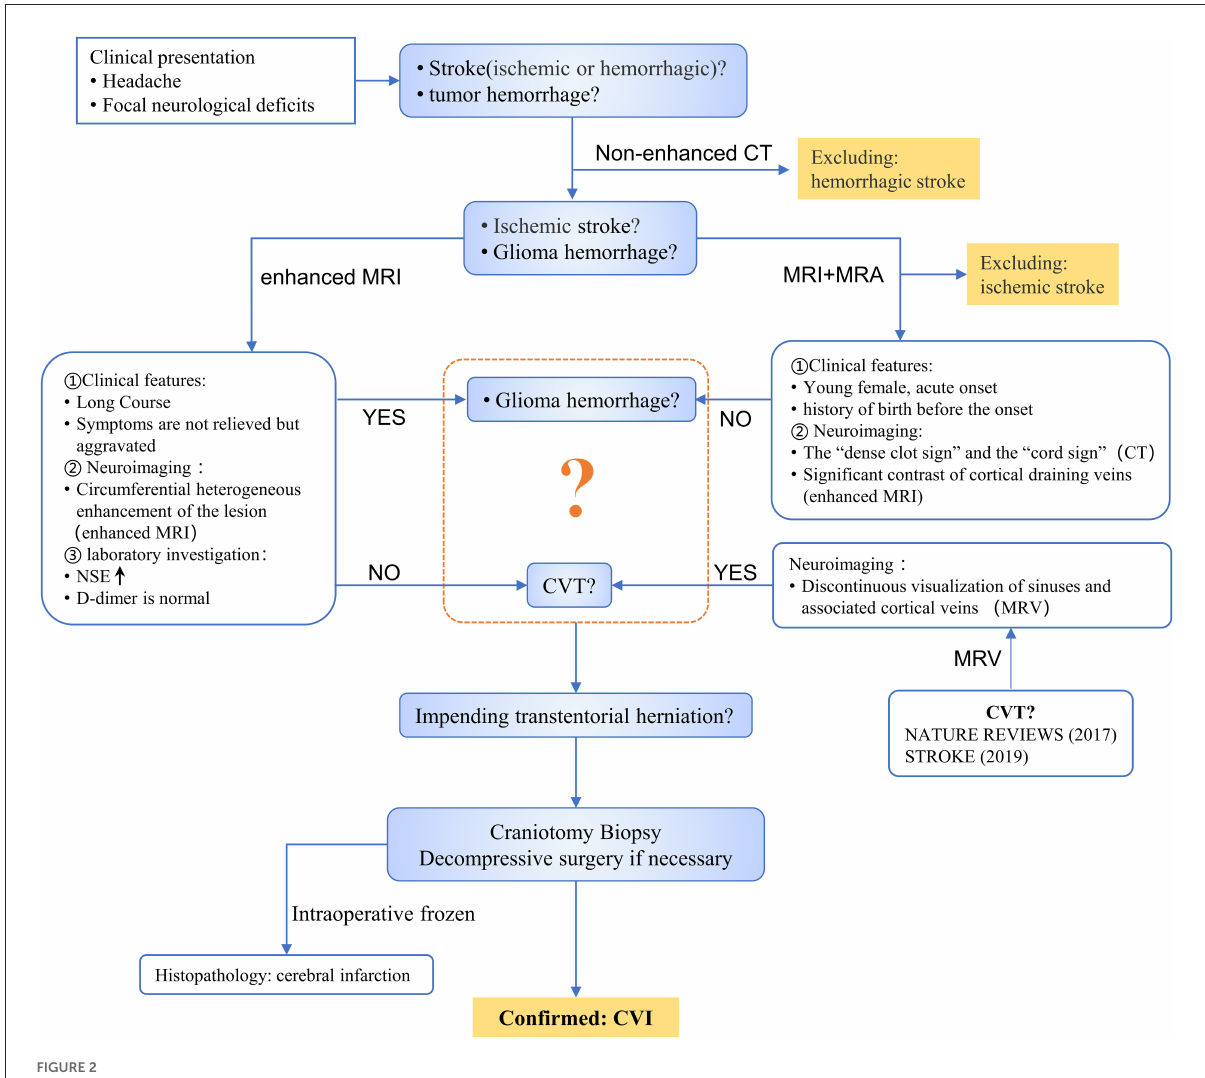
FIGURE2 Differential diagnosis and treatment process of